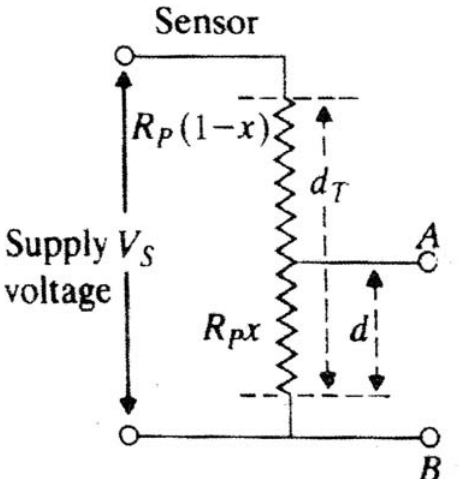
Figure 1. Arrangement of potentiometer-type displacement